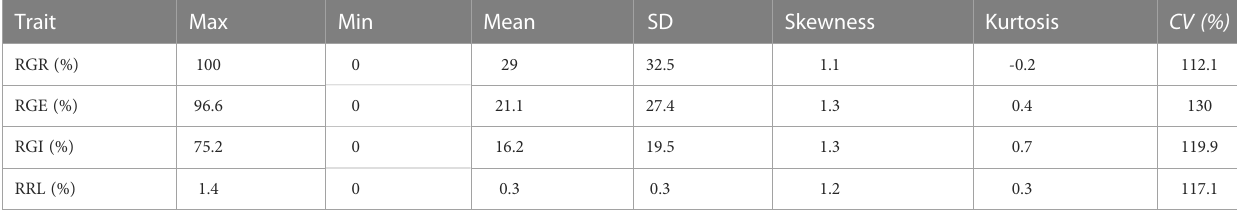
RGR, relative germination rate; RGE, relative germination energy; RGI, relative germination energy; RRL, relative radical length; SD, standard deviation; CV, Coef fi cient of